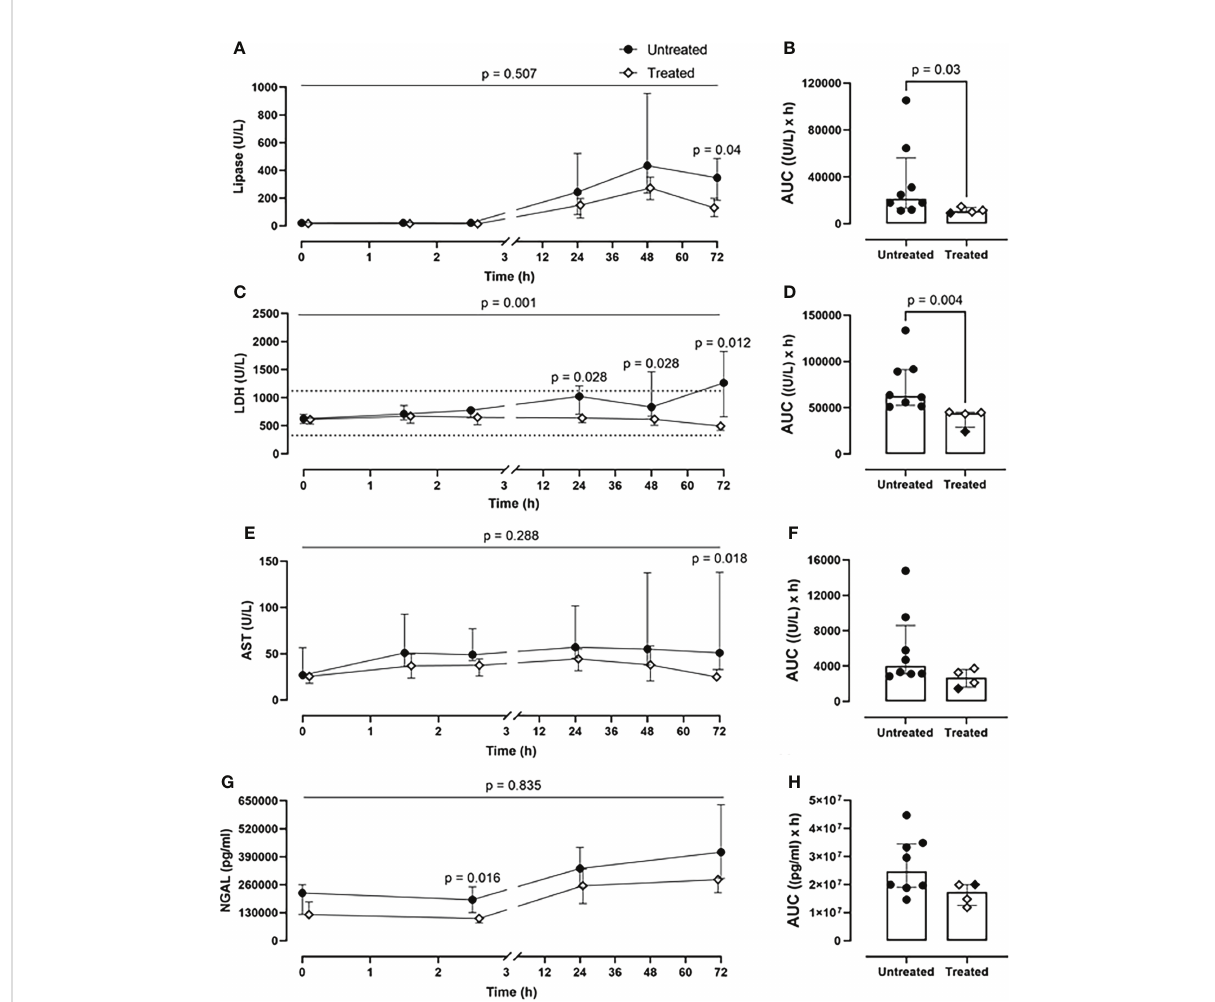
FIGURE 6 Organ damage markers. (A) Lipase, (C) LDH, (E) AST, and (G) NGAL monitoring in addition to (B) lipase, (D) LDH, (F) AST, and (H) NGAL AUC analysis showed that signi fi cantly lower lipase, LHD, AST, and NGAL values were detected in blood in the treated group (n=4), compared to the untreated group (n=8). Dotted lines represent the normal reference range. Overall p-value for group comparison of treated vs. untreated animals over time is displayed above the summary trajectories. In the AUC graphical representation, the fi rst pig, receiving lower inhibitor dosage, is represented as black fi lled